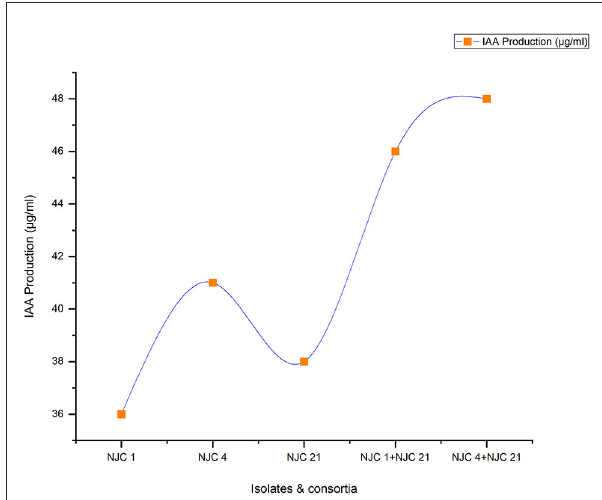
FIGURE5 IAA production by isolates and consortia.